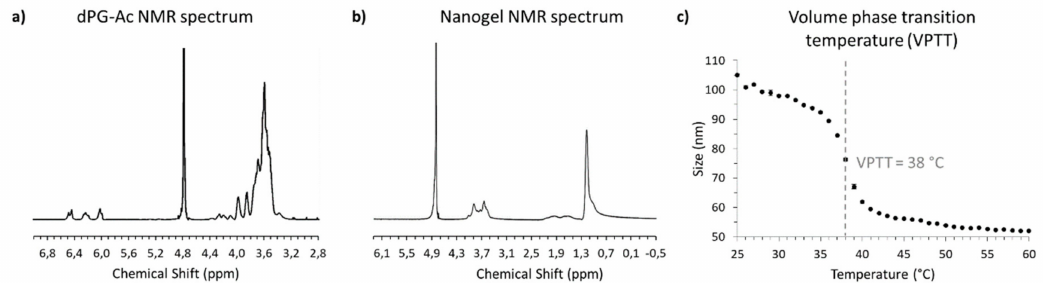
Figure 3. ( a ) 1 H-NMR spectrum of acrylated dendritic polyglycerol (dPG-Ac). ( b ) 1 H-NMR spectrum of the nanogels confirming its constitution. ( c ) Nanogel size vs. temperature curve obtained by dynamic light scattering (intensity). The VPTT defined as the temperature of the inflection point of this curve is 38 ◦